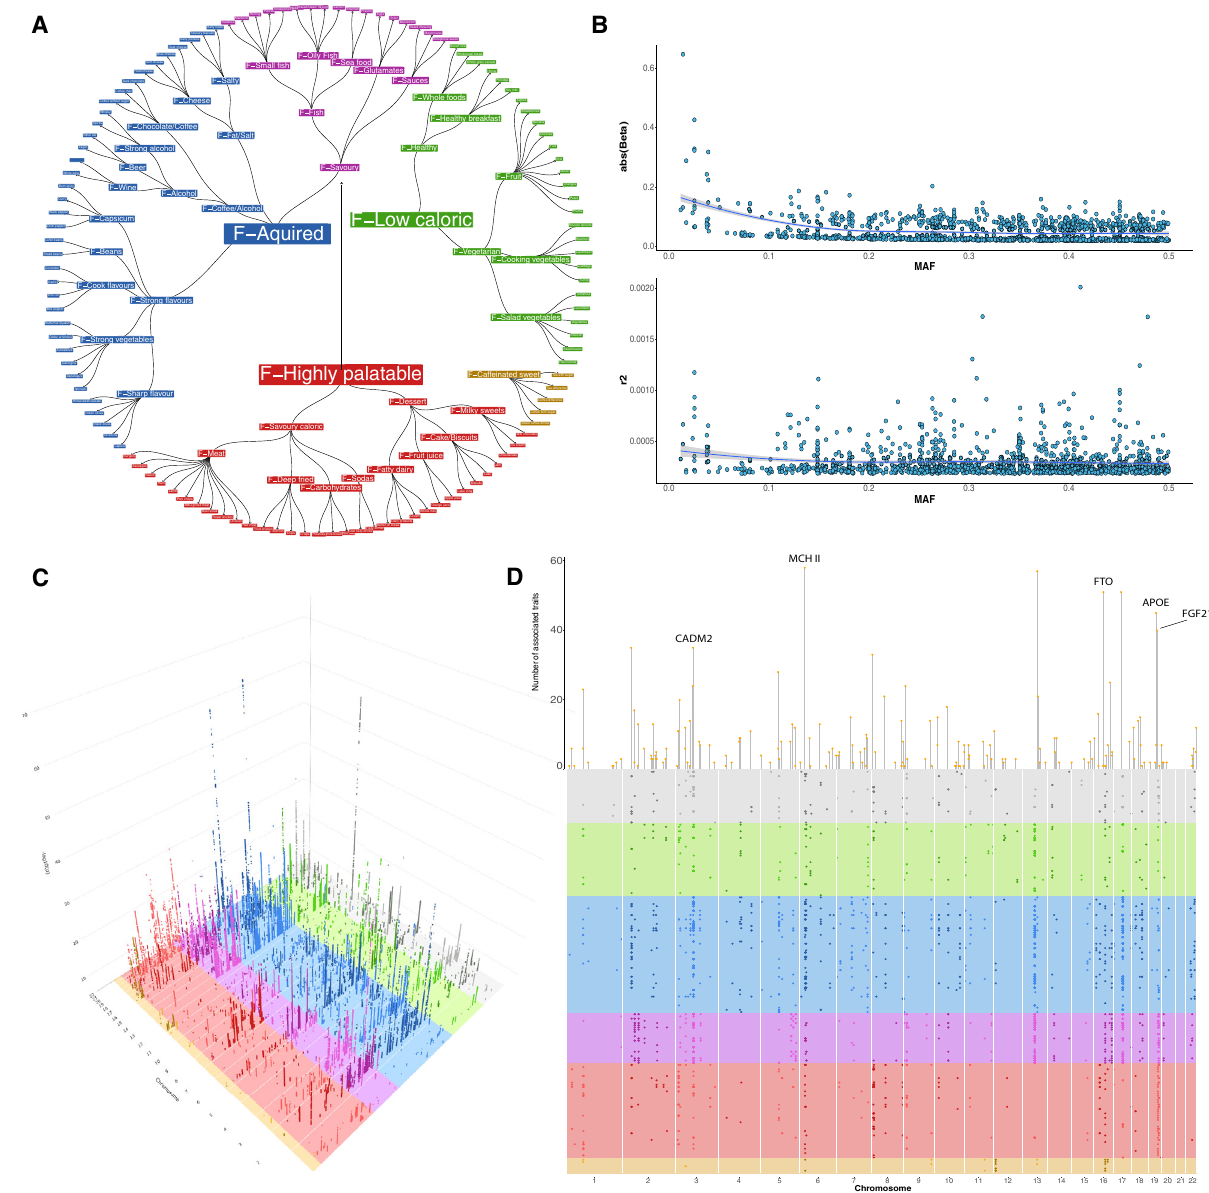
Fig. 1 Food-liking map and genome-wide association results. Panel A displays the hierarchical model of relationships between liking of different foods. The outermost branches represent the original food-liking traits which were measured with the questionnaire. Colours re fl ect the membership in one of the four independent dimensions: Red: F-Highly palatable; Blue: F-Acquired; Green: F-Low Caloric; Light brown: F-Caffeinated sweet drinks. F-Savoury foods are coloured purple as they contribute to both F-Highly palatable and F-Acquired Foods. The upper half of panel B represents the relationship between the minor allele frequency and effect size. As in most complex traits, there is an inverse relationship between MAF and effect size. The lower panel represents the same SNPs but r 2 is reported on the y -axis, showing no relationship between the two measures. The lines represent the trend line with 95% CI. Panel C is a 3D Manhattan plot, reporting only SNPs with p < 5 × 10 − 8 . Colours re fl ect those used in panel A . Panel D shows a bird ’ s-eye view of the Manhattan plot. Each dot represents the top SNP from each of the sub-loci. The lollipop heights are proportional to the number of traits each locus is associated